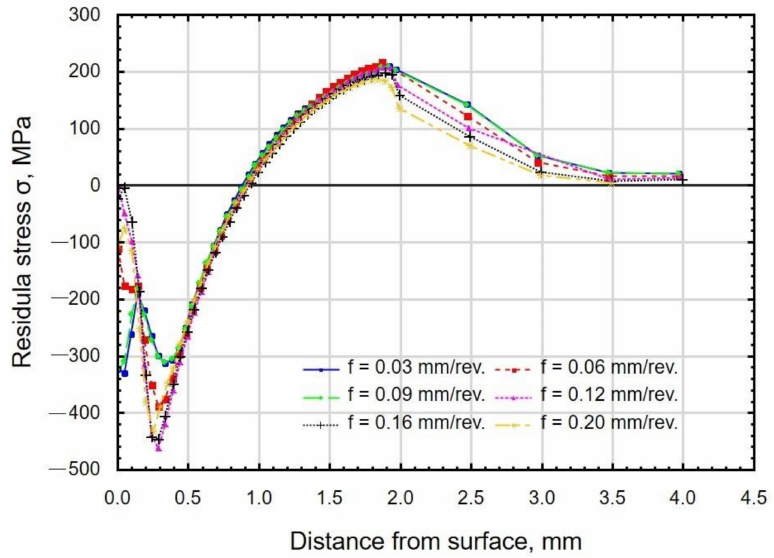
Figure 15. Distribution of residual stresses as a function of distance from the surface of X6CrNiTi18 steel samples after slide burnishing with a variable feed ( F = 230 N; v n = 35 m/min; i = 1; R = 3